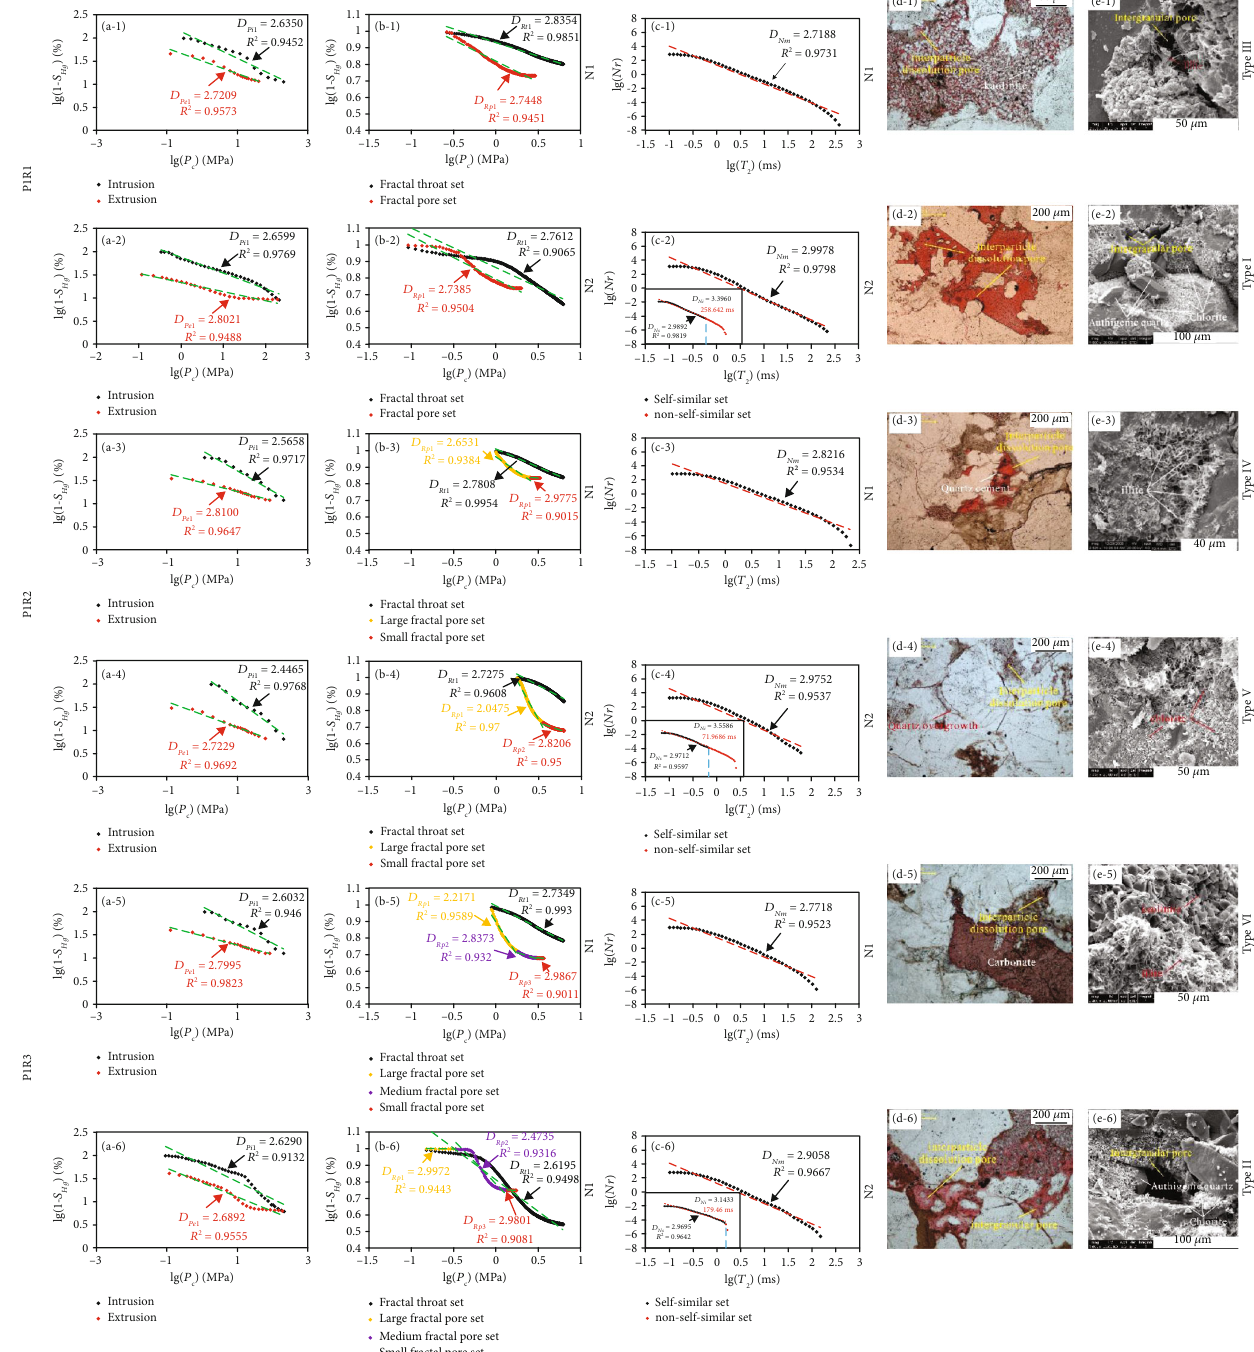
Figure 14: (a) Multifractal distributions proposed by PCMI tests; (b) multifractal distributions proposed by RCMI tests; (c) fractal distributions proposed by NMR tests; (d) TS for pore geometry and mineralogical analysis; (e) SEM images for mineral features. Typical specimen of type I from S29, type II from S27, type III from S39, type IV from S47, type V from S26, and type VI from